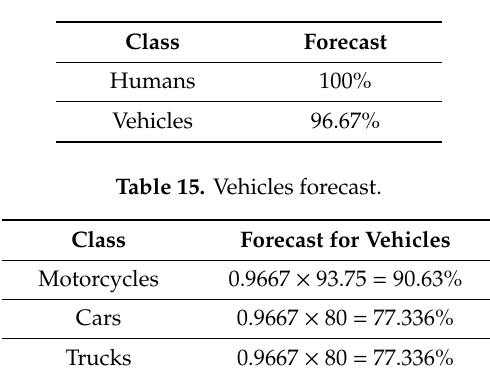
Table 14. Main forecast.